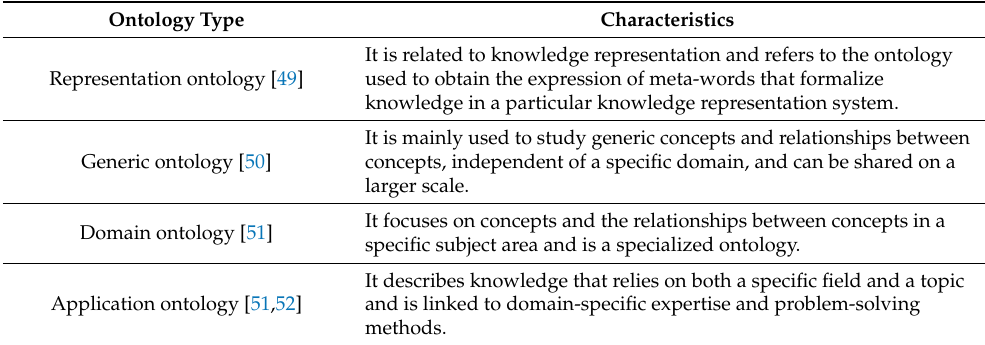
Table 1. Classification of ontologies.